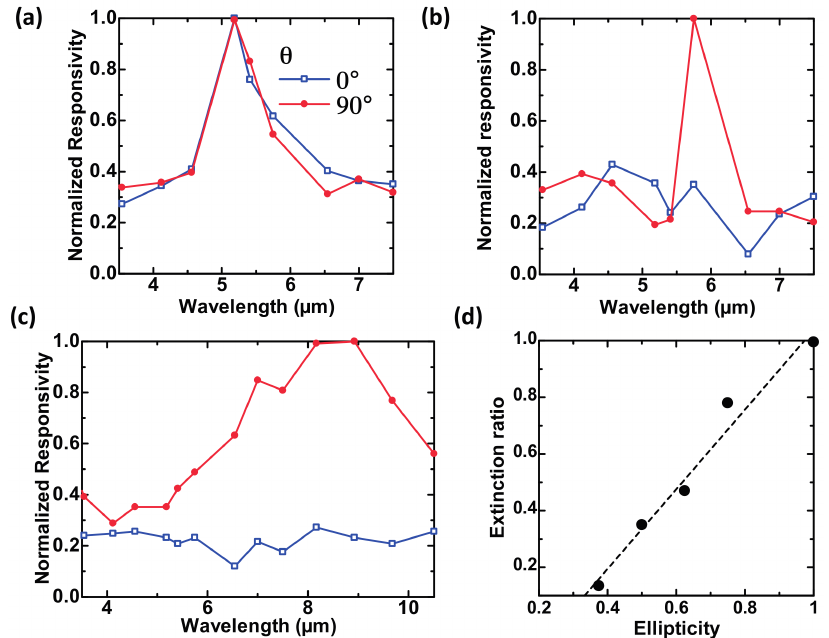
Figure 9. Measured polarization dependence of spectral responsivity of developed uncooled IR sensors using 2D-PAs with ( a ) circular and ( b ) ellipsoidal dimples, and with ( c ) 1D-PAs. ( d ) Relationship between the extinction ratio and the